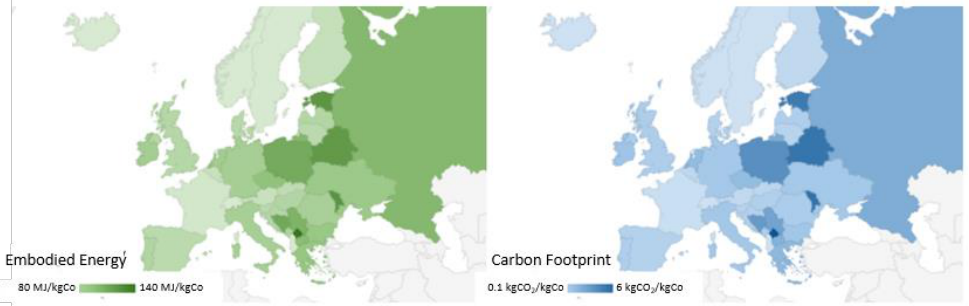
Figure 6. Evaluation of Embodied Energy and Carbon Footprint for Co extraction process by Ferreira et al., 2008 (process n ◦ 2 of Table 1) [21], according to the national energy mix.